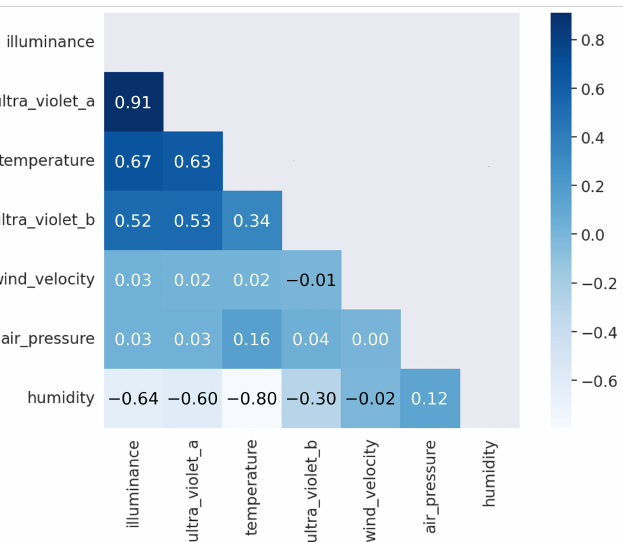
Figure 7. The hourly average of illuminance values over the period of nine months, from February to October 2022.